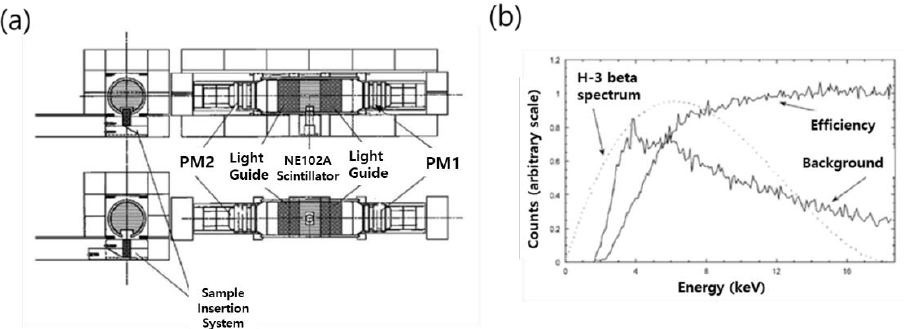
Figure 3. Drawing of a plastic detector for beta-ray measurement ( a ) and energy spectrum ( b ) [29].